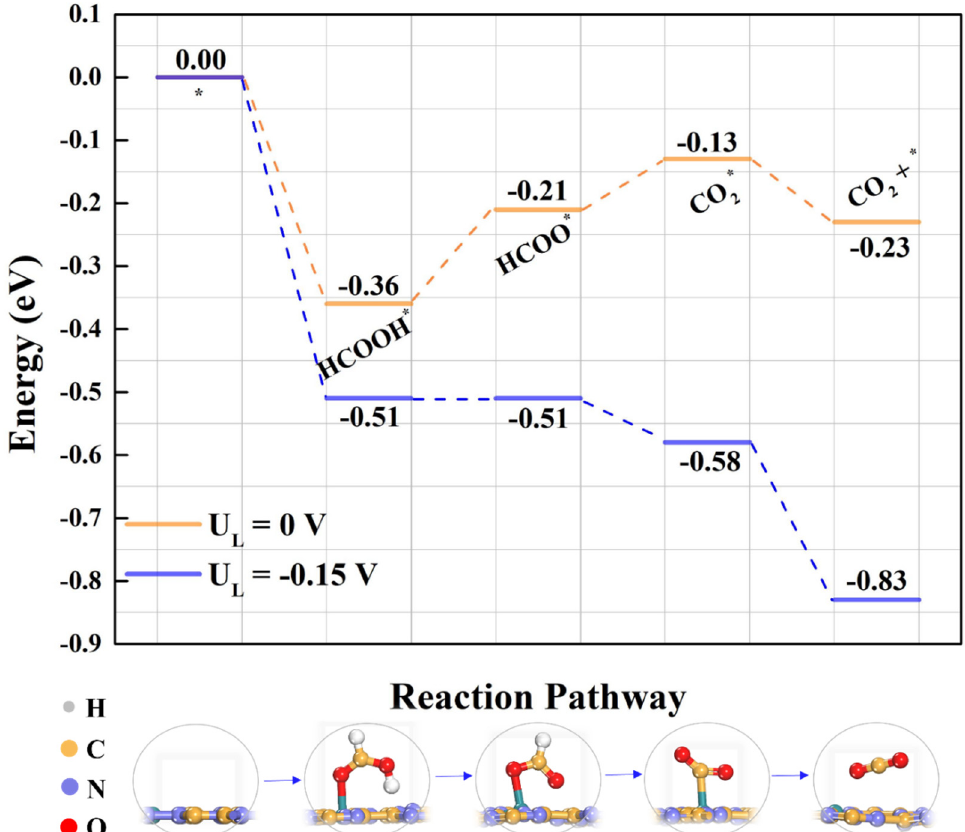
Figure 4. Free energy diagram of FAOR on Ru/g-CN via the direct pathway, and the corresponding structures of FAOR intermediates.